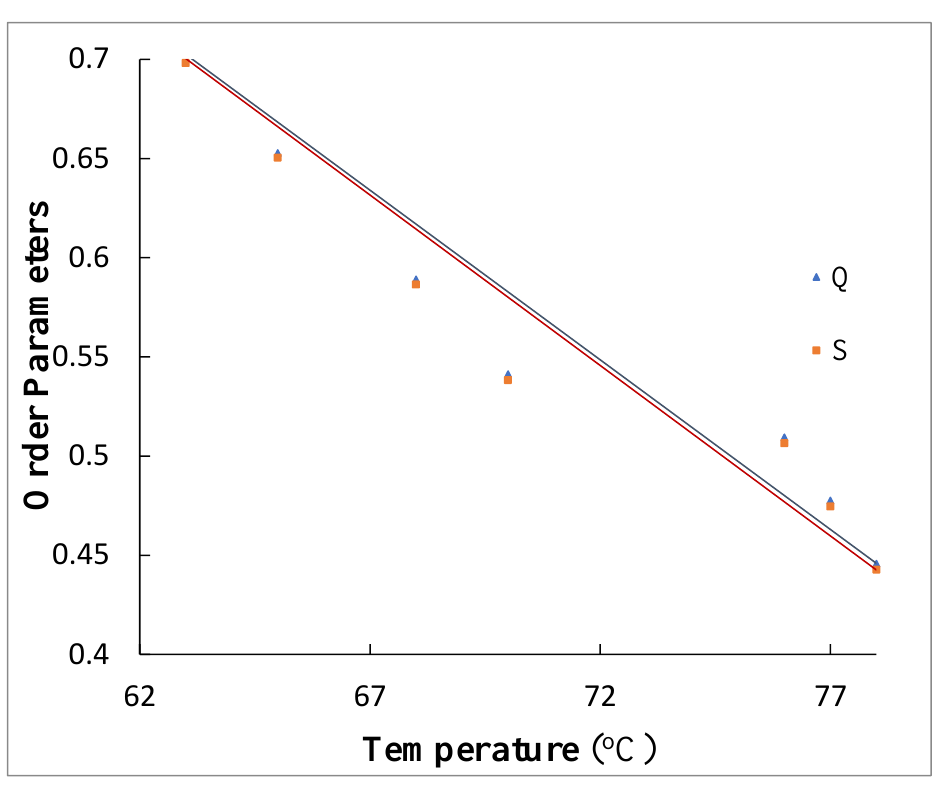
Figure 9. The relationship between parameters (Q and S ) and temperature for compound I .